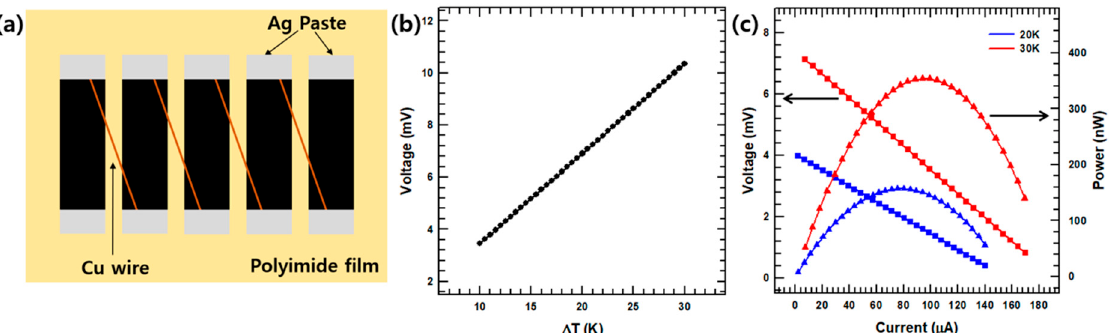
Figure 8. The structure and performance of the flexible TE prototype device: ( a ) schematic diagram of the TE device structure; ( b ) the open-circuit voltage at various temperature differences; ( c ) the output voltage and power versus current at temperature differences of 20 and 30 K.